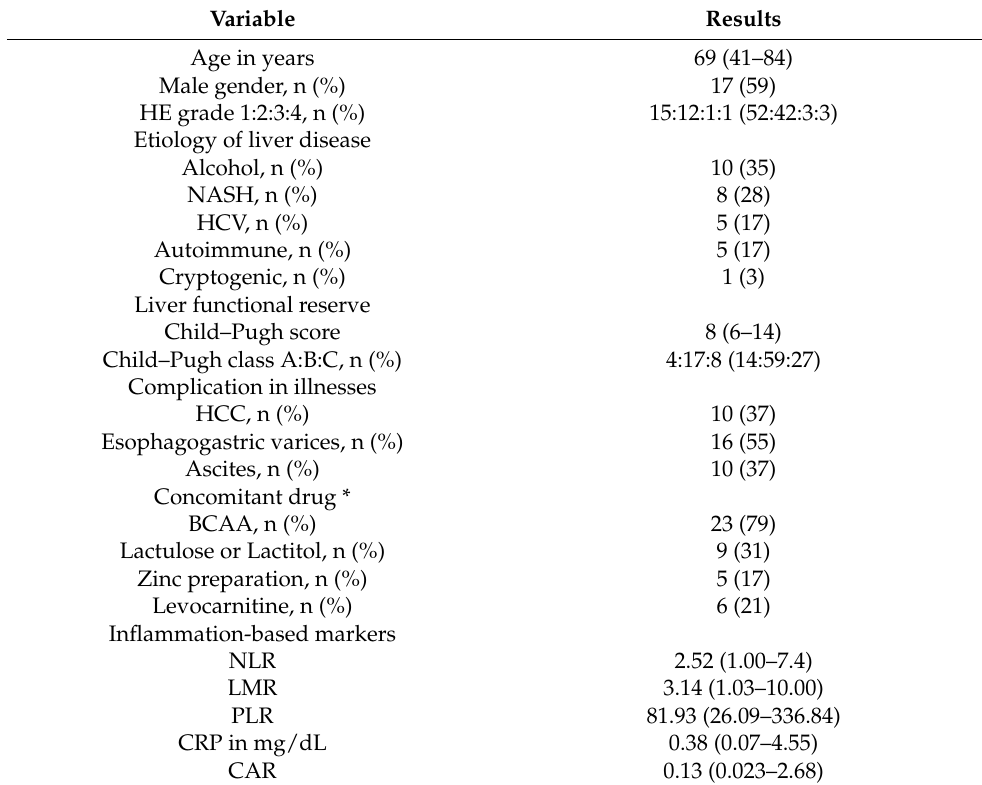
Table 2. Clinical characteristics of the patient at baseline (Examination